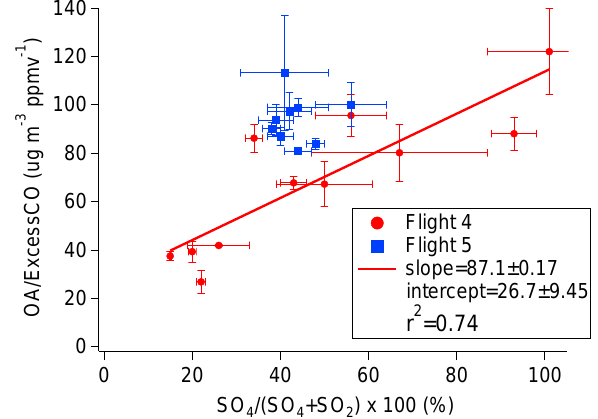
) × 100 /(SO 2 +SO 2 − 4 4